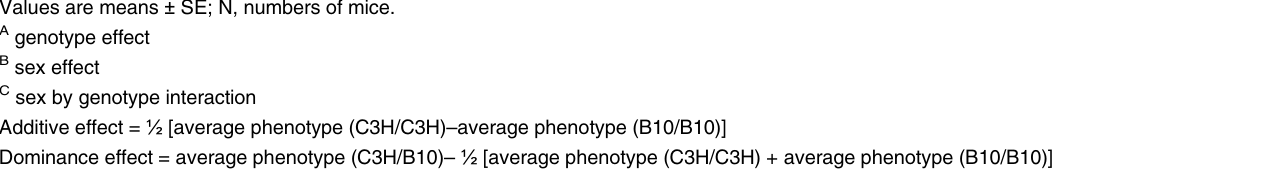
chromosome 4 congenic segment had reduced total displacement and had lower max load than homozygous C3H/C3H mice. marized in Table B in S1 File. Males had greater post yield strain (p = 0.010) than females across all genotypes. However, there were no significant differences in other tissue level proper- ties across all genotypes. Additive and Dominance Effects of C.B.4.3 Mice. Genotype-dependent differences in trait values can be partitioned into additive and dominance effects. These are defined and sum- marized in Table 4. For OMJA and MOI, the locus had a significant additive effect in both sexes. For CSA, the locus had a significant dominance effect in males and a significant additive effect in females. The locus had a significant dominance effect in both sexes for shape factor. In